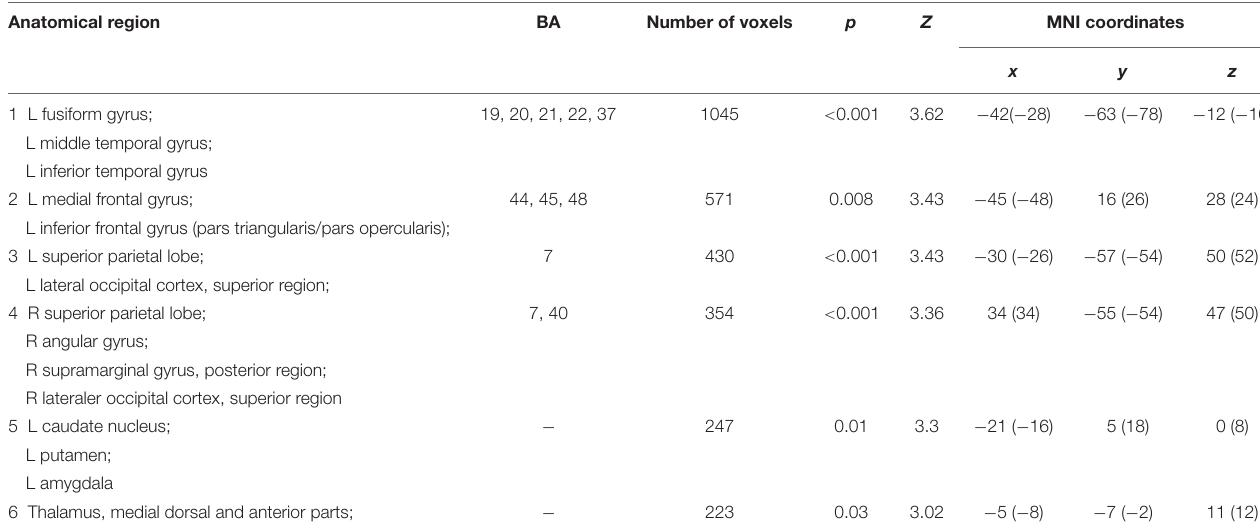
TABLE 4 | Activation clusters for the contrast between successfully encoded > not successfully encoded insight solutions. Anatomical region